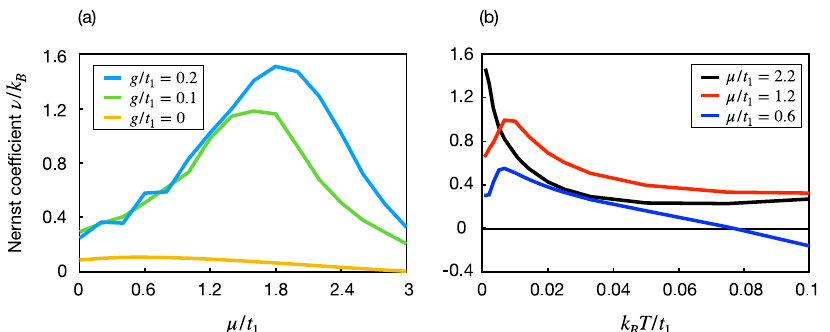
Fig. 6 Calculated Nernst coef fi cient under variation of further parameters. a Nernst coef fi cient as a function of the chemical potential μ for two different values of g and fi xed temperature k B T = 0.01. The broad maximum at intermediate μ values (for g ≠ 0) is comparable with the observed behaviour of the Nernst effect as a function of doping as it has been found by our measurements. For comparison, we also show the result without taking into account nematic coupling ( g = 0), which shows a very reduced amplitude. b Nernst coef fi cient as a function of temperature for different values of μ and fi xed g = 0.1. As observed in the experiments, we fi nd a μ -dependent low temperature maximum followed by a rapid decrease and saturation at high T . The maximum appears when the thermal energy k B T is of the same order as the experimentally found value k B T c for the superconducting T c